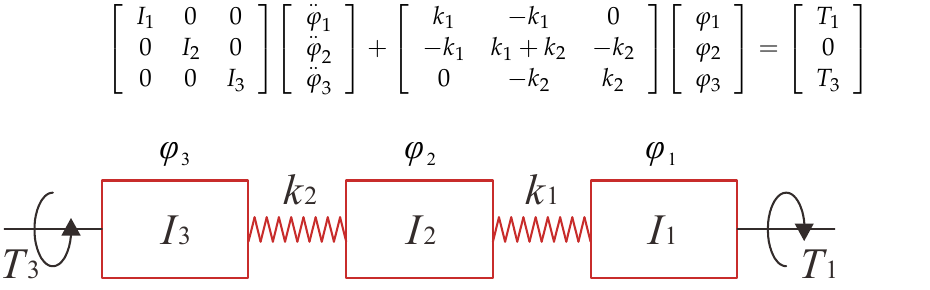
Figure 4. Schematic of the drive chain for the knee pitch motion using a mass-spring model. The term T 1 denotes the motor’s output torque acting on the proximal end of the linkages for driving the knee pitch motion; the term T 3 denotes the torque for driving the parts of the robot via the knee pitch motion.